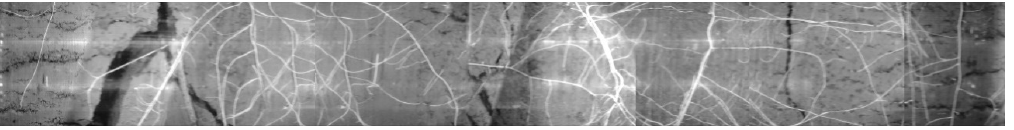
Figure 10. A 360° view of canola root taken by SoilCam (after stitching 10 images together). Figure 10. A 360 ◦ view of canola root taken by SoilCam (after stitching 10 images together).